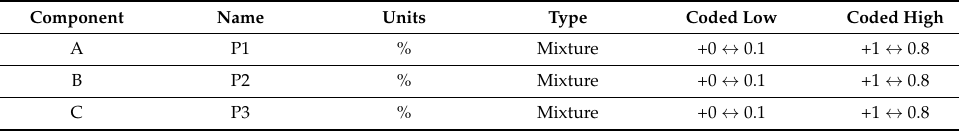
Table 5. Components of the mixing plan and its